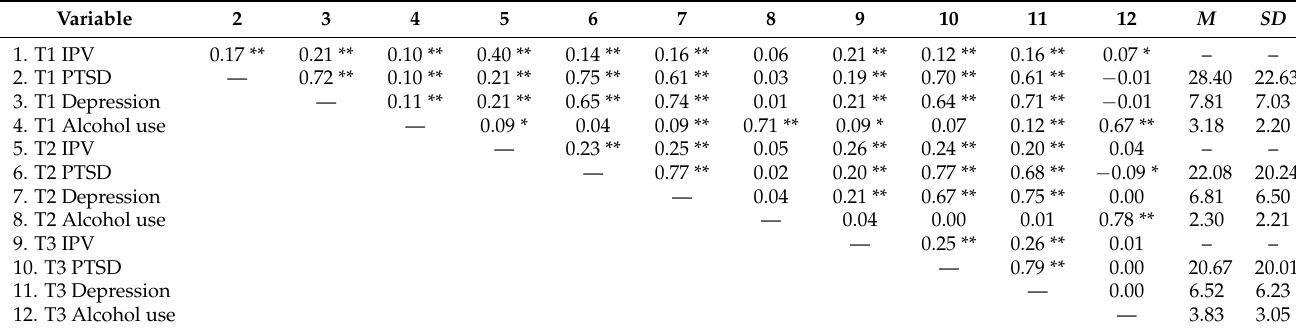
Table 2. Descriptive statistics and correlations among variables of interest.